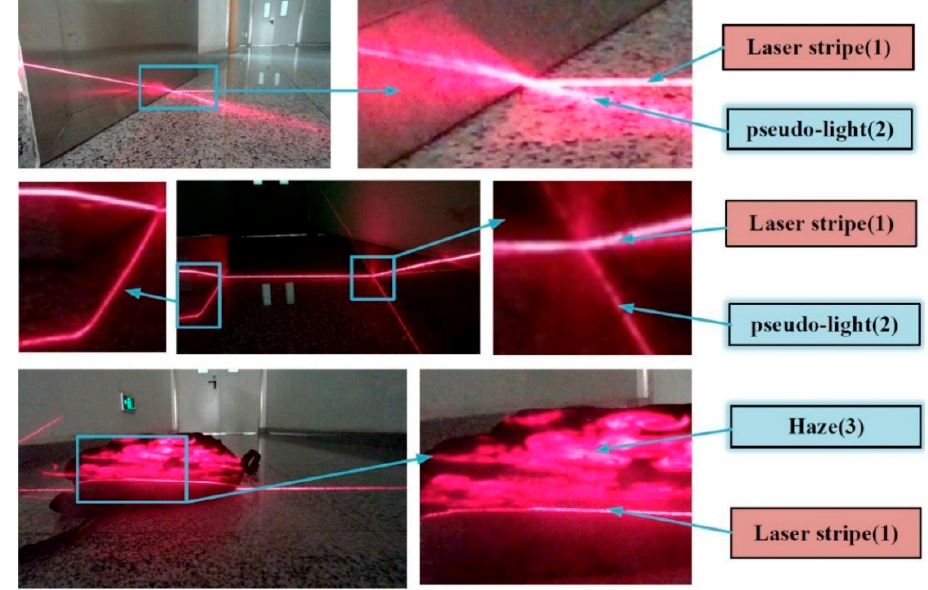
ff erent laser stripes in real Figure 1. Different laser stripes in real images. Figure 1. Di